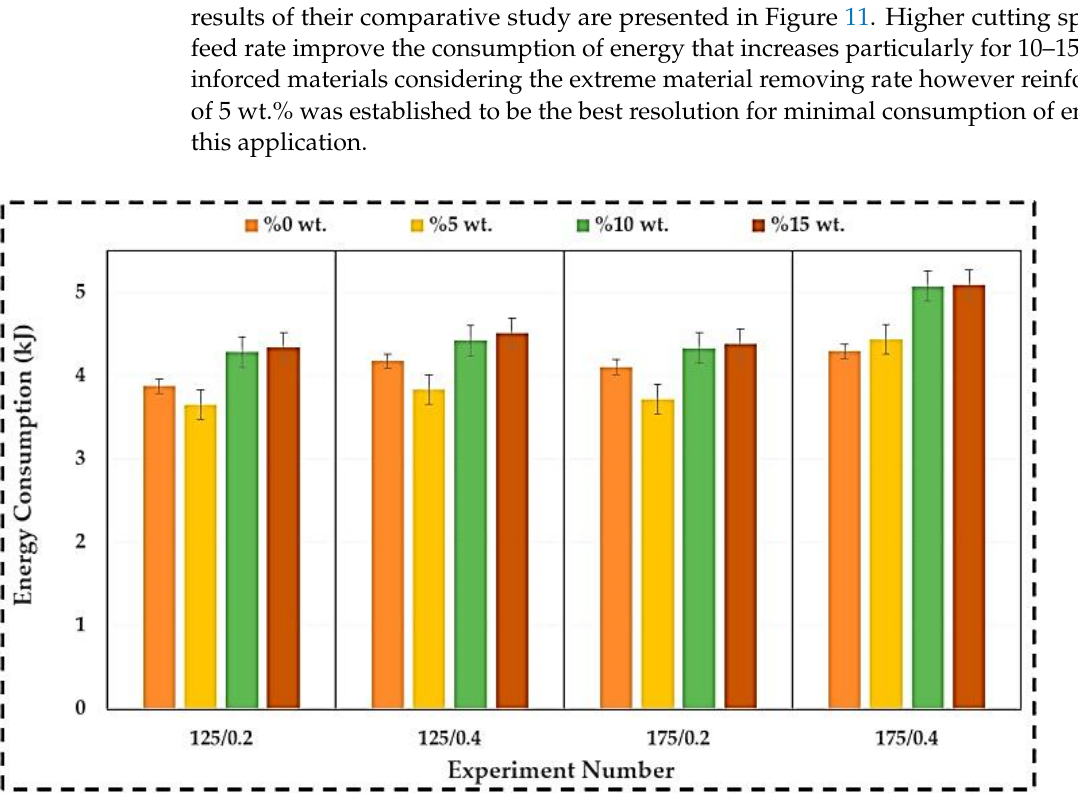
Figure 11. Comparison of reinforcement ratio on energy consumption [145].